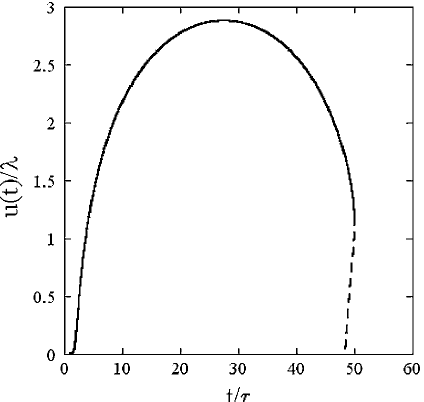
¼ p ¼ (cid:2) B . The figure is p v